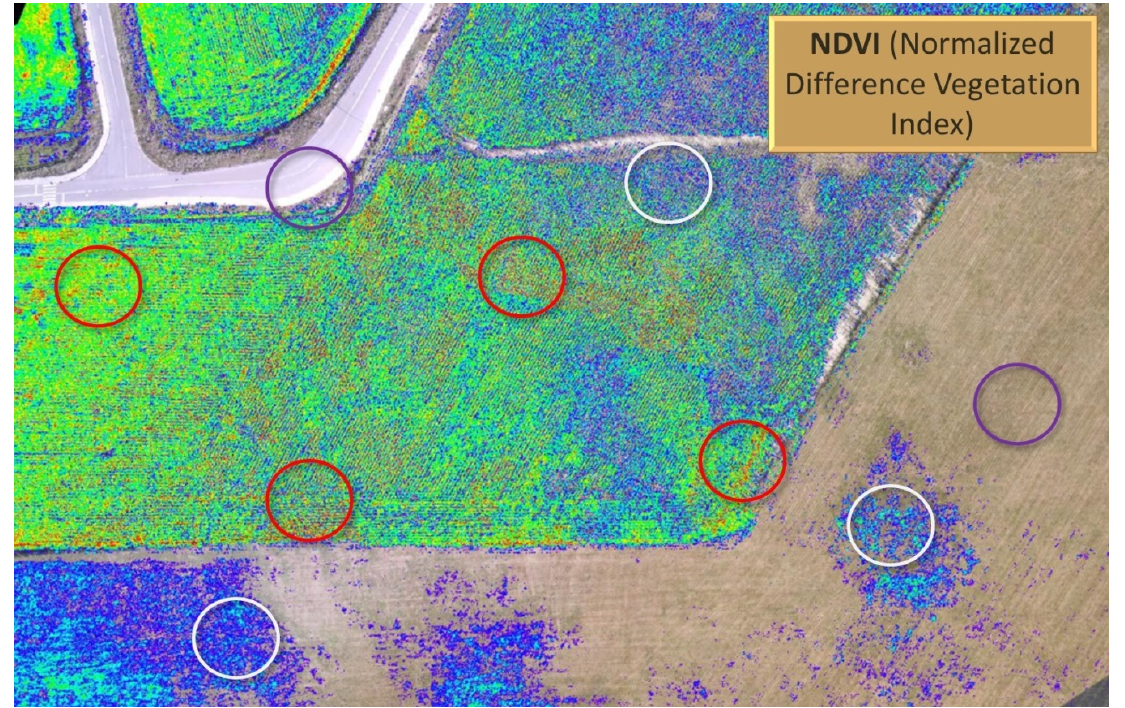
Figure 14. Remote sensing system in use to obtain high-quality multispectral imaging.